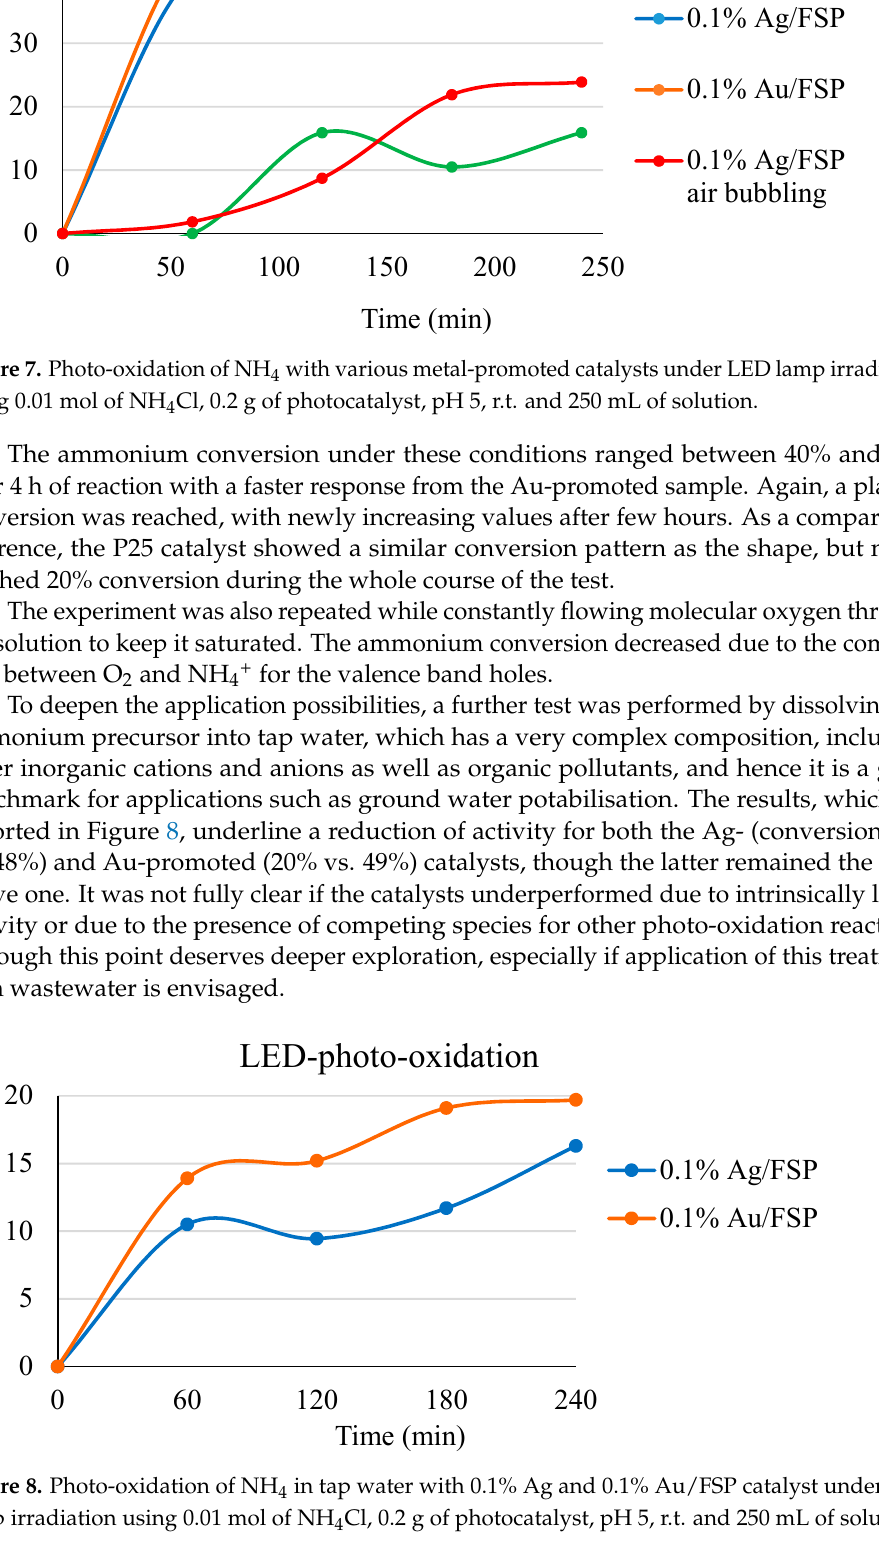
Figure 8. Photo-oxidation of NH 4 in tap water with 0.1% Ag and 0.1% Au/FSP catalyst under LED lamp irradiation using 0.01 mol of NH 4 Cl, 0.2 g of photocatalyst, pH 5, r.t. and 250 mL of solution.